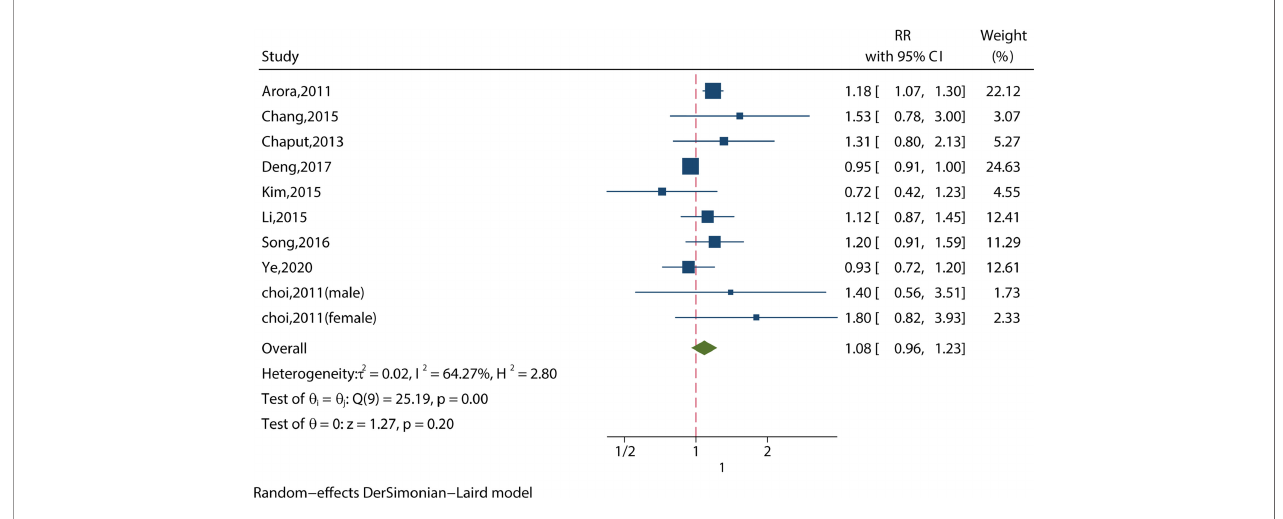
FIGURE 5 | Meta-analysis of the association between long sleep and risk of metabolic syndrome from crude models or least-adjusted